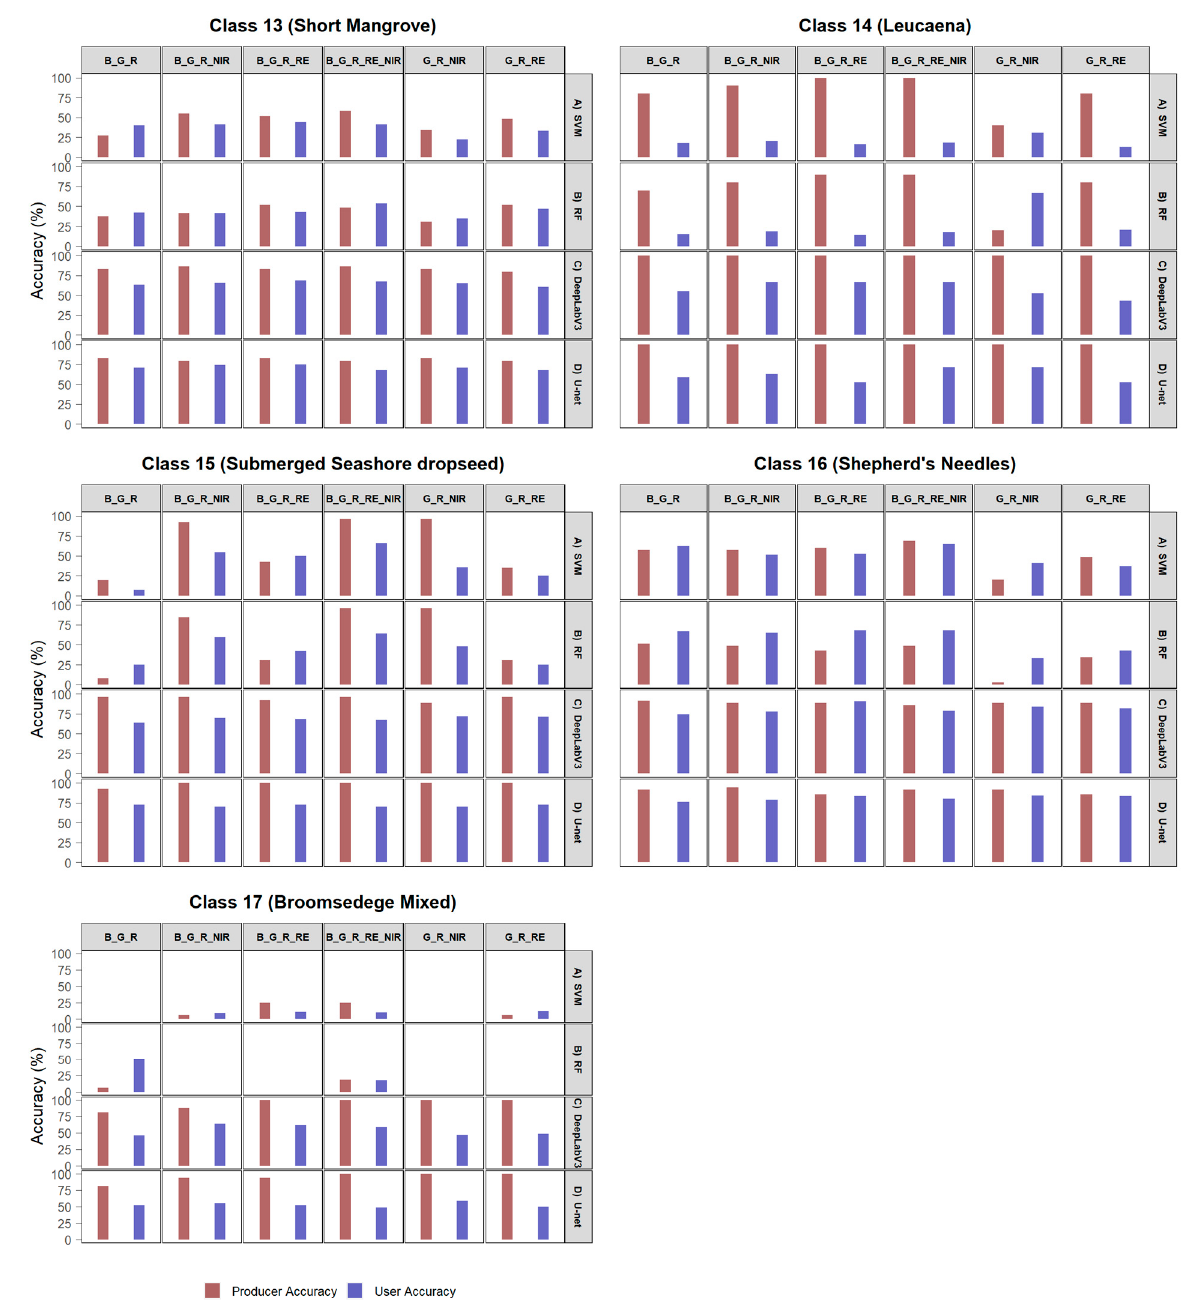
Figure A3. Experiment: EXP1-OSB, producer and user accuracy organized by class and classification method, classes 13 to 17.